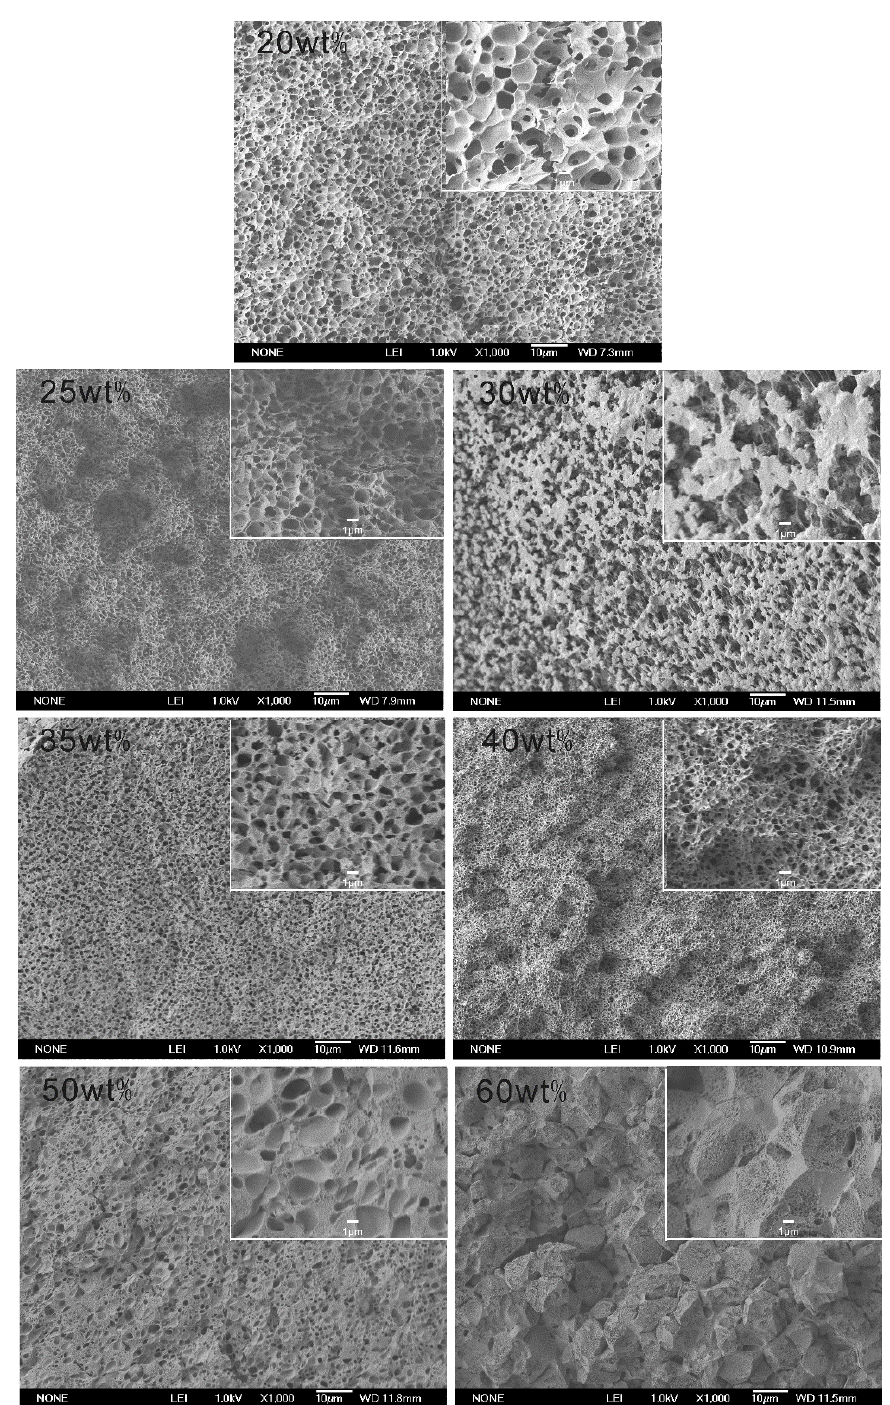
Figure 8. SEM micrographs of PVDF c2 membranes prepared from MS dilutions quenched in the ice water bath (the polymer content is marked in the upper left corner of each